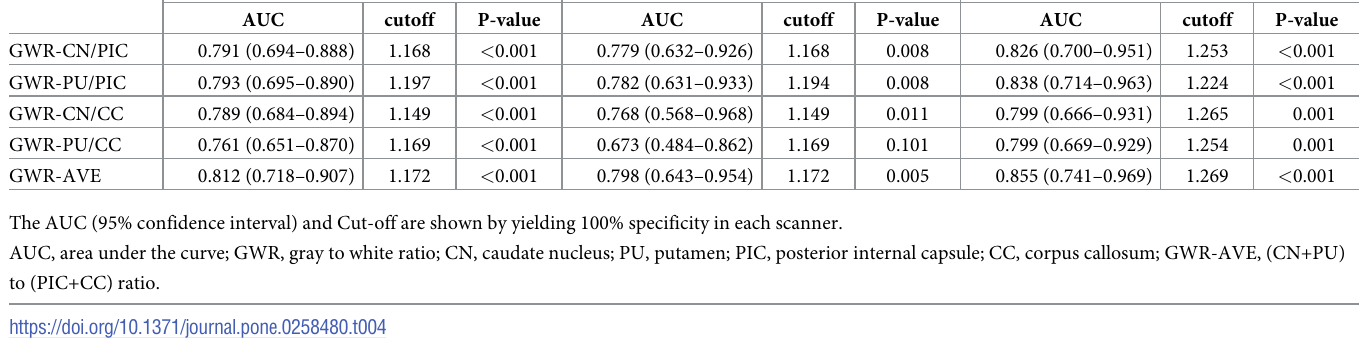
Table 4. AUC value and a cut-off value of GWR for each CT scanner. All patients (n =